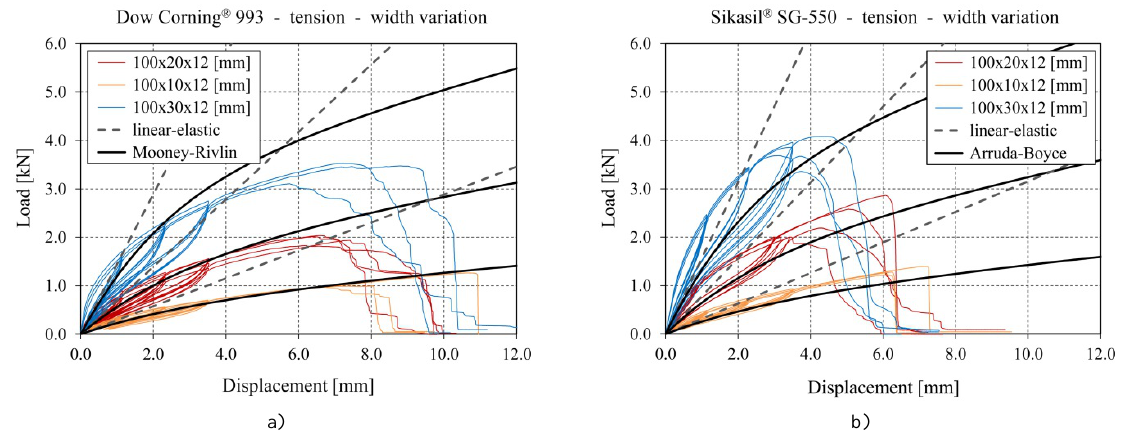
Fig. 7 Load vs. displacement results from the tensile tests on linear adhesive joints with different widths compared to results obtained by finite element simulations for a) joints with Dow Corning ® 993 and b) joints with Sikasil ® SG-550.